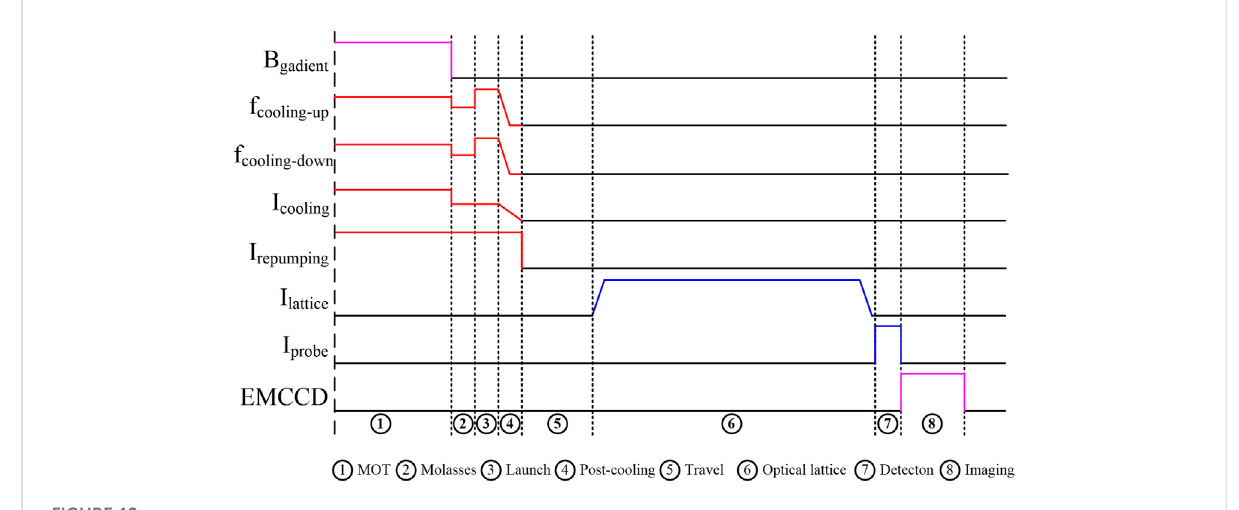
FIGURE 12 Time sequence for the preparation and loading of cold atoms for optical